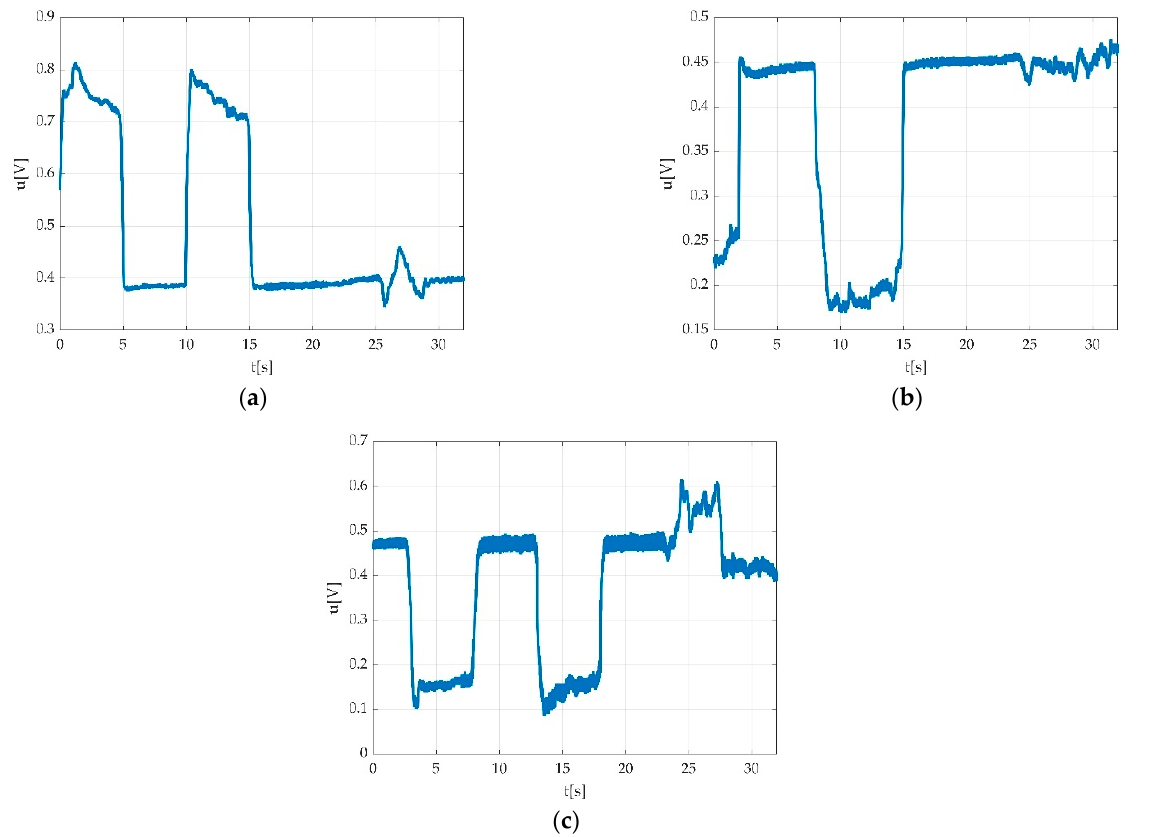
Figure 24. Example of invalid measurement due to improper tester command; ( a ) operator forgot to ask for third MVIC; ( b ) operator forgot to command relaxation; ( c ) while dorsiflexion command would have normally followed, the operator requested a plantar flexion command.